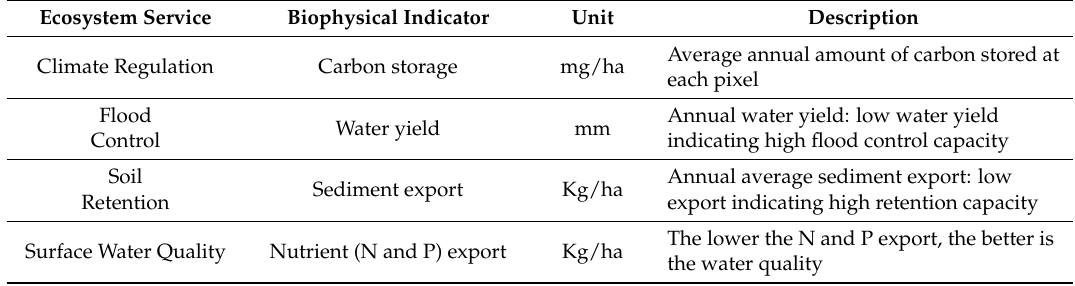
Table 1. Ecosystem services assessed in this study and their biophysical